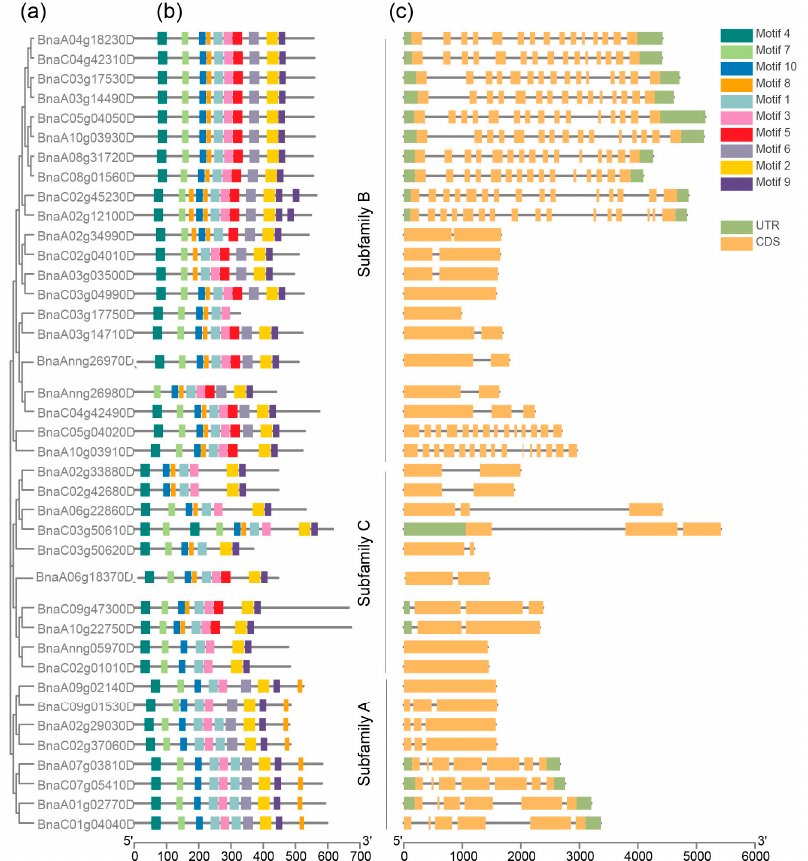
Figure 3. The phylogenetic relationship, conserved motifs and gene structure of ARI genes in B. napus . ( a ) The phylogenetic relationship of BnARI proteins. ( b ) The motif composition of BnARI proteins. Motifs (1–10) are shown in different colored boxes. ( c ) Gene structures of the BnARI genes. Orange boxes represent the CDS whereas green boxes represent UTR.